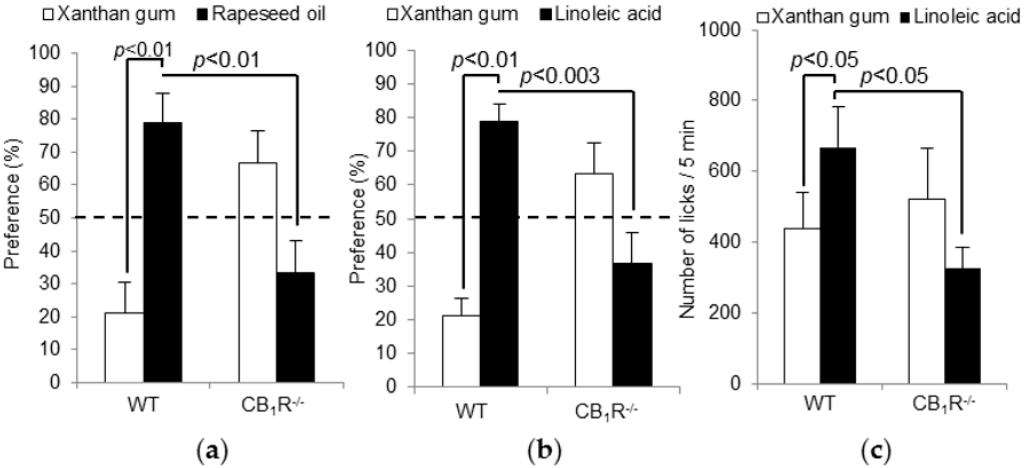
Figure 1. Effect of CB 1 R gene invalidation on preference for lipids. Two bottles (control and experimental) were simultaneously offered to wild type (WT) and CB 1 R − / − mice for 12 h. The experimental solution contained ( a ) 0.2% of rapeseed oil ( w / v ); ( b ) 0.2% of linoleic acid ( w / v ) diluted in xanthan gum. The control solution contained 0.3% of xanthan gum ( w / v ). Values are expressed as mean ± SEM ( n = 10). Dotted line represents the absence of preference in CB 1 R − / − mice (less than 50% of preference). ( c ) Short-term (5 min) licking tests in WT and CB 1 R − / − mice were performed as described in Materials and Methods. Animals were subjected to a control solution (xanthan gum) and an experimental solution containing 0.2% of linoleic acid. Values are expressed as mean ± SEM ( n = 9).